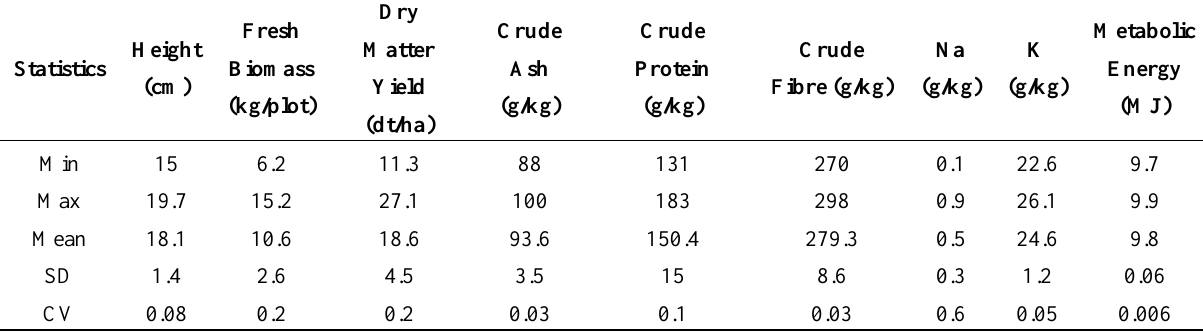
Table 4. Summary statistics for the selected grassland features of the October harvest. (SD: Standard Deviation; CV: Coefficient of